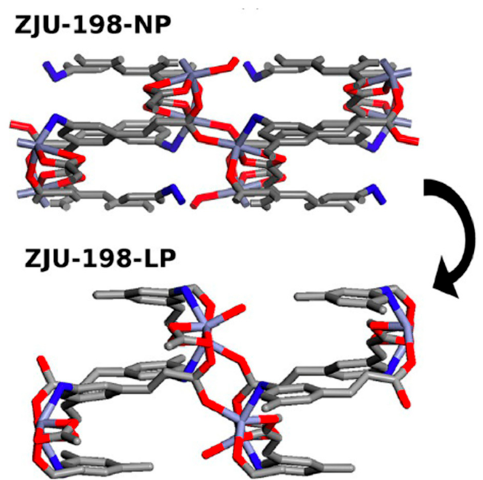
Figure 23. NP and LP conformations of ZJU-198 framework. Reproduced with permission from [90]. Copyright Wiley-VCH, Copyright Wiley-VCH, 2018.